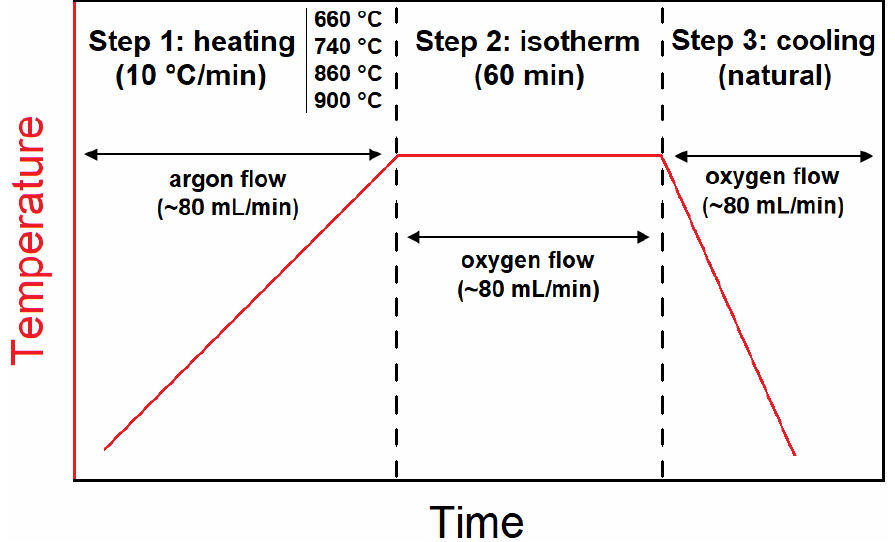
Figure 2. Experimental procedure adopted for isothermal thermogravimetric